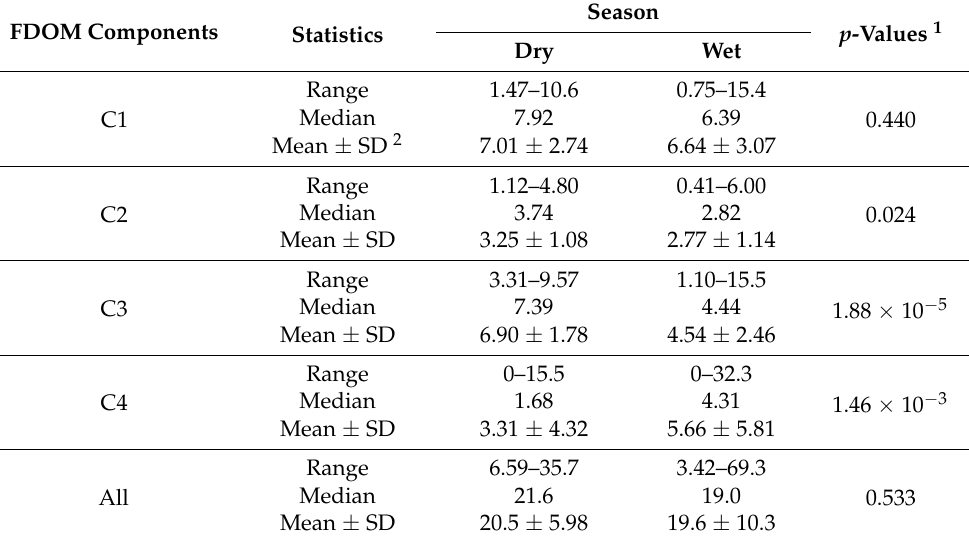
Table 1. Temporal variations of FDOM components in urban river of Jinan, China. FDOM